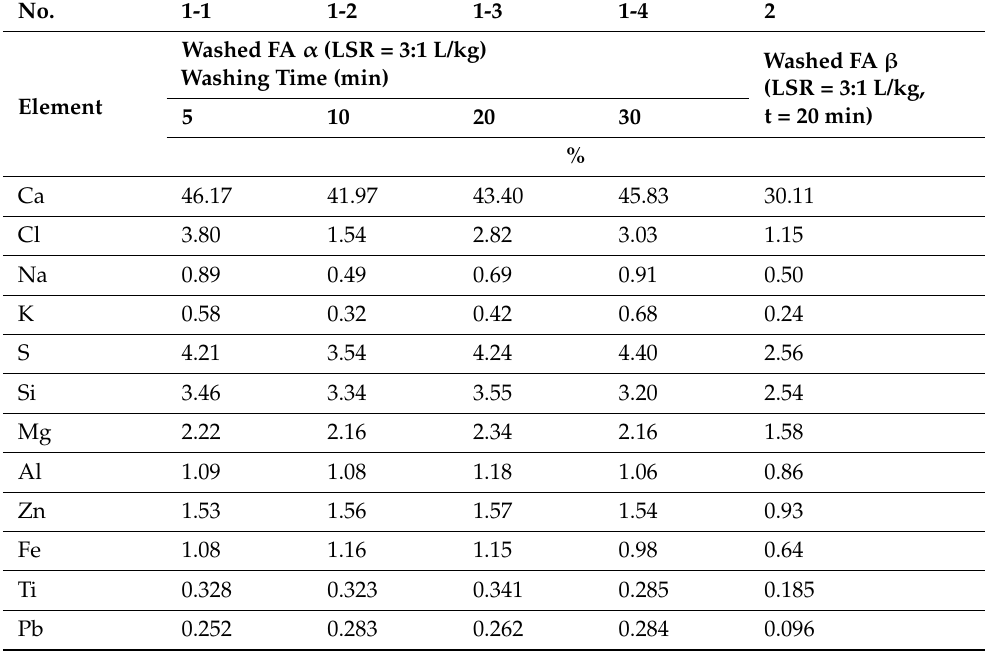
Table 6. The XRF results of the main elements in different fly